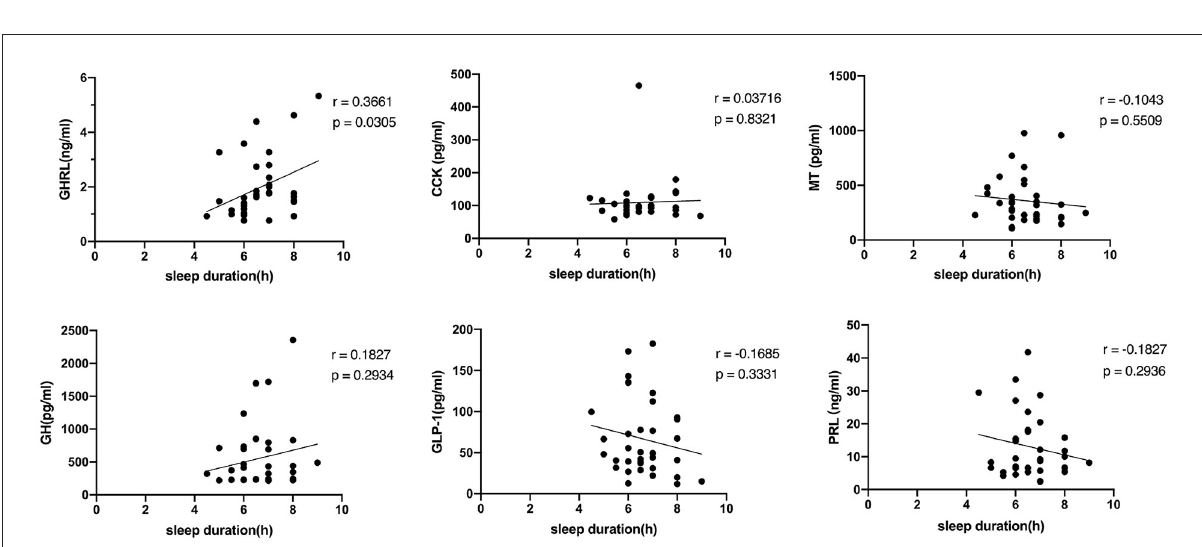
FIGURE6 The relationship between the serum indicators and sleep duration. GHRL, ghrelin; CCK, cholecystokinin; MT, melatonin; GH, growth hormone; GLP-1, glucagon-like peptide-1; PRL, prolactin.